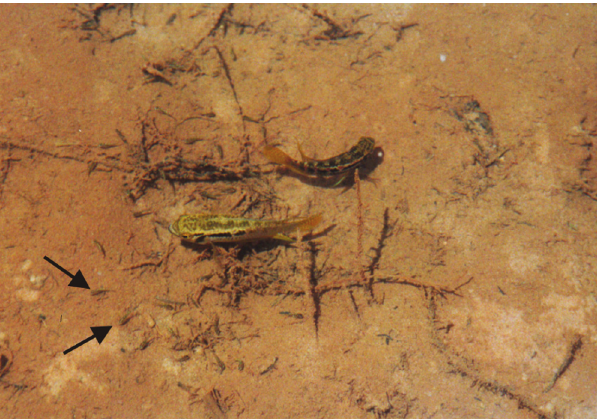
Fig. 1. A pair of Laetacara araguaiae with fry (arrows). The largest fish is the male. Photo: Elias F. Lopes de